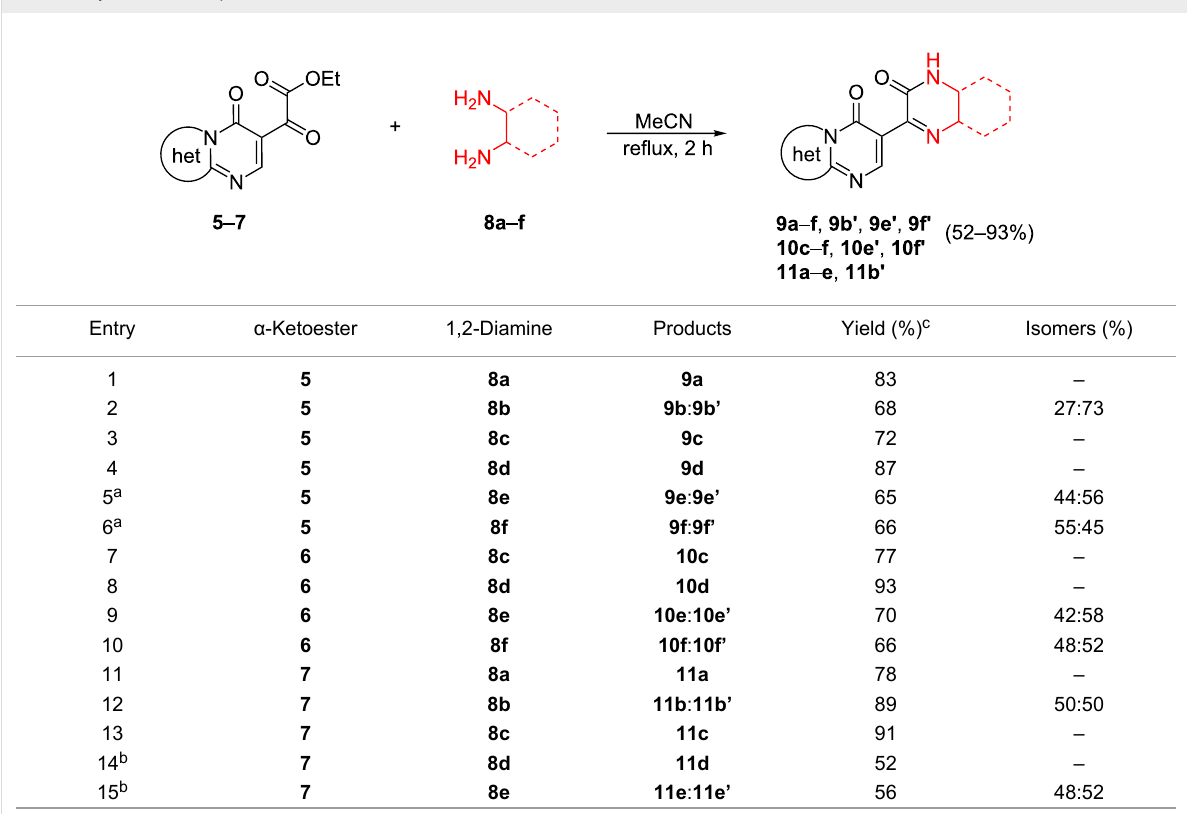
Table 5: Synthesis of compounds 9a–f , 9b' , 9e' , 9f' , 10c–f , 10e' , 10f' , 11a–e and 11b' .